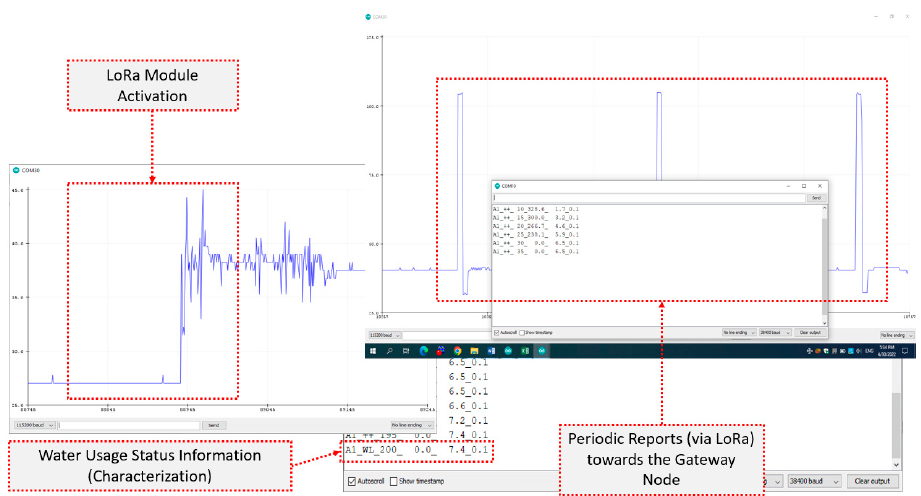
Figure 10. Characteristic short-time dynamics for the LoRa communication alternative: From the LoRa module activation ( left ) to the energy peaks reflecting the packet transmission events ( top right ) and to the corresponding textual information content as intercepted by the gateway ( bottom right ).